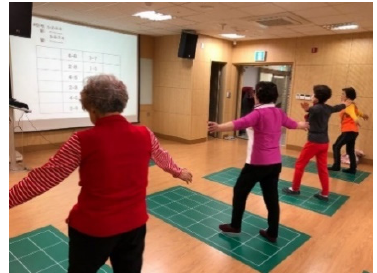
Figure 1. Visual memory program in cognitive walking program